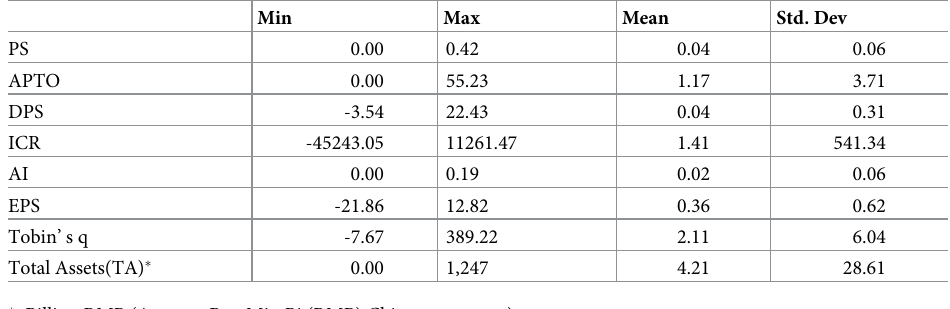
Table 1. Descriptive statistics: Full